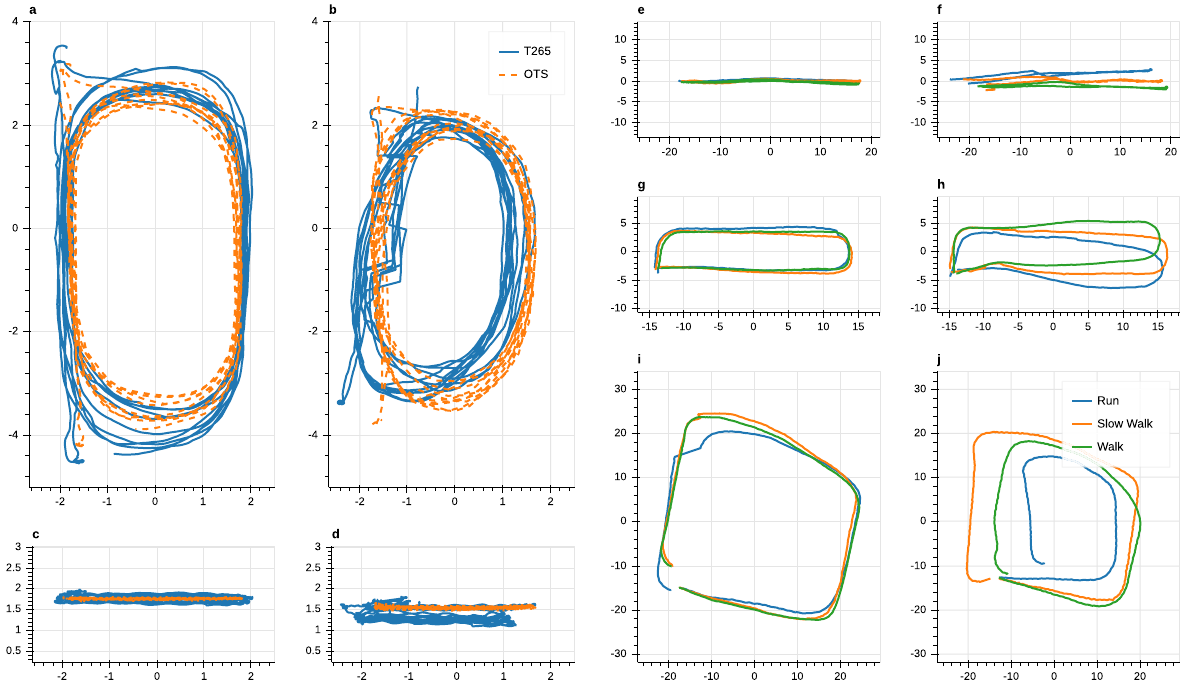
Figure 3. Example trajectories recorded in all environments. All axes indicate position in m; axis labels were omitted to avoid cluttering. ( a–d ) Top and side view of trajectories recorded in the optical tracking space comparing position estimated by T265 (blue) and OTS (orange, dashed). ( a,c ) Successful tracking during walking. ( b,d ) Unsuccessful tracking exhibiting re-localizations and drift in both vertical direction and yaw during running. ( e–j ) Top view of example trajectories recorded in the real-world environments comparing position estimated by T265 across different tasks (blue: running, orange: slow walking, green: walking). ( e ) Successful tracking in hallway environment. ( f ) Unsuccessful tracking in hallway environment exhibiting yaw drift and re-localization. ( g ) Successful tracking in lobby environment. ( h ) Unsuccessful tracking in lobby environment exhibiting yaw drift. ( i ) Successful tracking in courtyard environment. ( j ) Unsuccessful tracking in courtyard environment exhibiting yaw drift and task-dependent under-estimation of displacement.